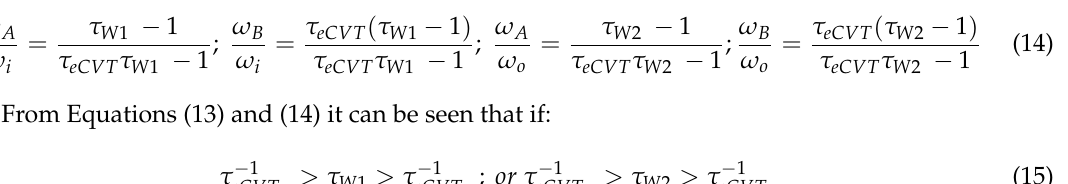
Figure 3. Examples of τ gl as a function of τ eCVT in four cases, depending on the minimum and maximum limits.